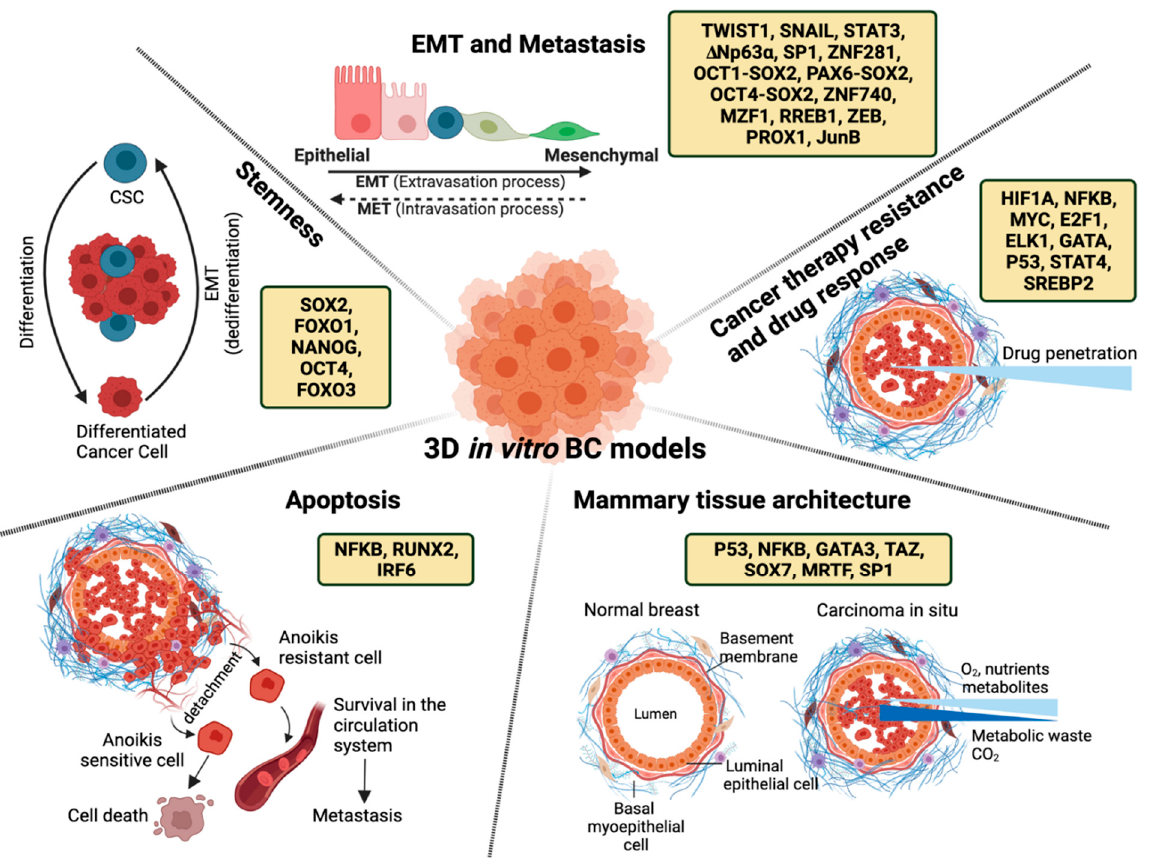
Figure 3. Transcription factors regulating mammary tissue architecture, EMT and metastasis, apoptosis, stemness, and drug response in 3D in vitro breast cancer models. Table 2. Transcription factors (TFs) in BC pathogenesis studied in 3D culture.